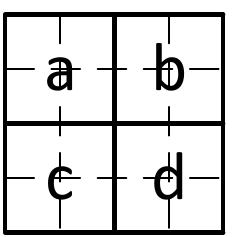
Figure 3. The process of changing the unit module.